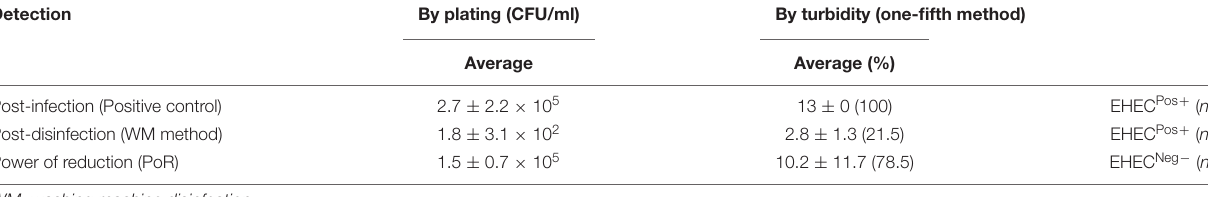
TABLE 1 | The result of artificially contaminated beef with EDL933 treated by WM method. Detection By plating (CFU/ml) By turbidity (one-fifth method)